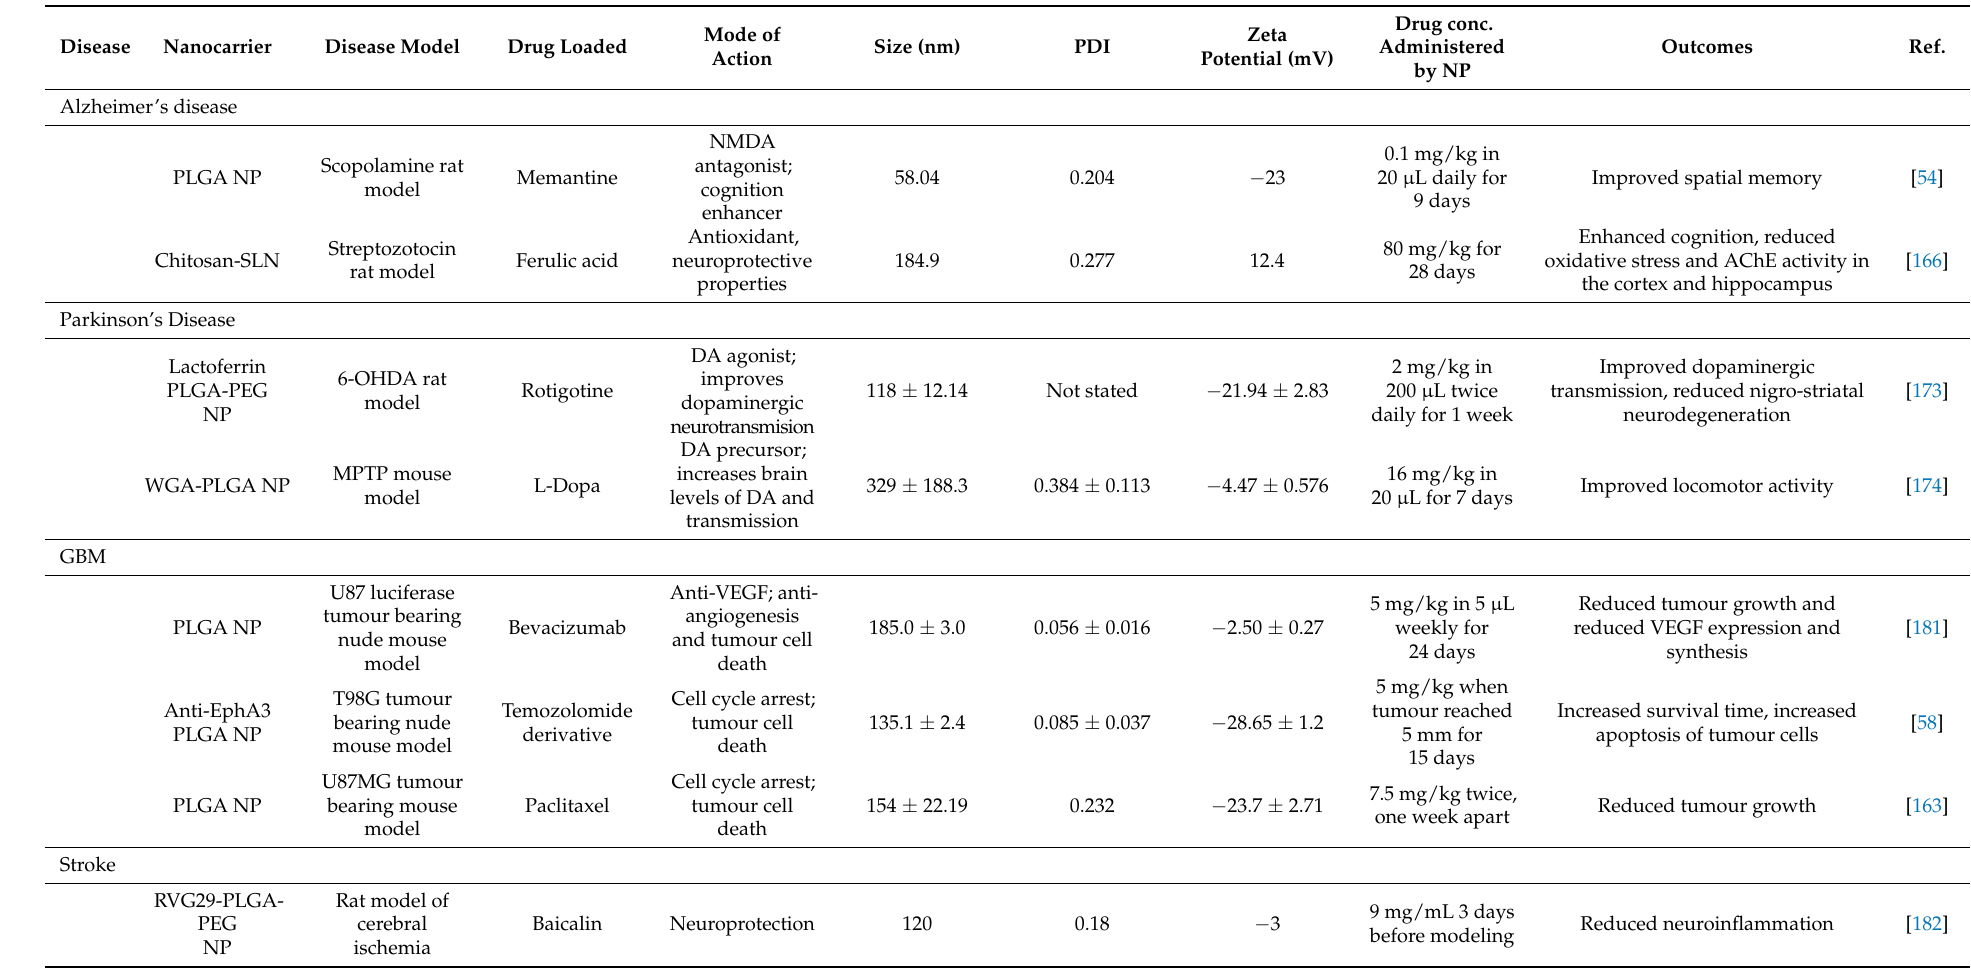
Table 2. The physicochemical properties of PLGA NPs and SLNs delivered intranasally to animal models of CNS